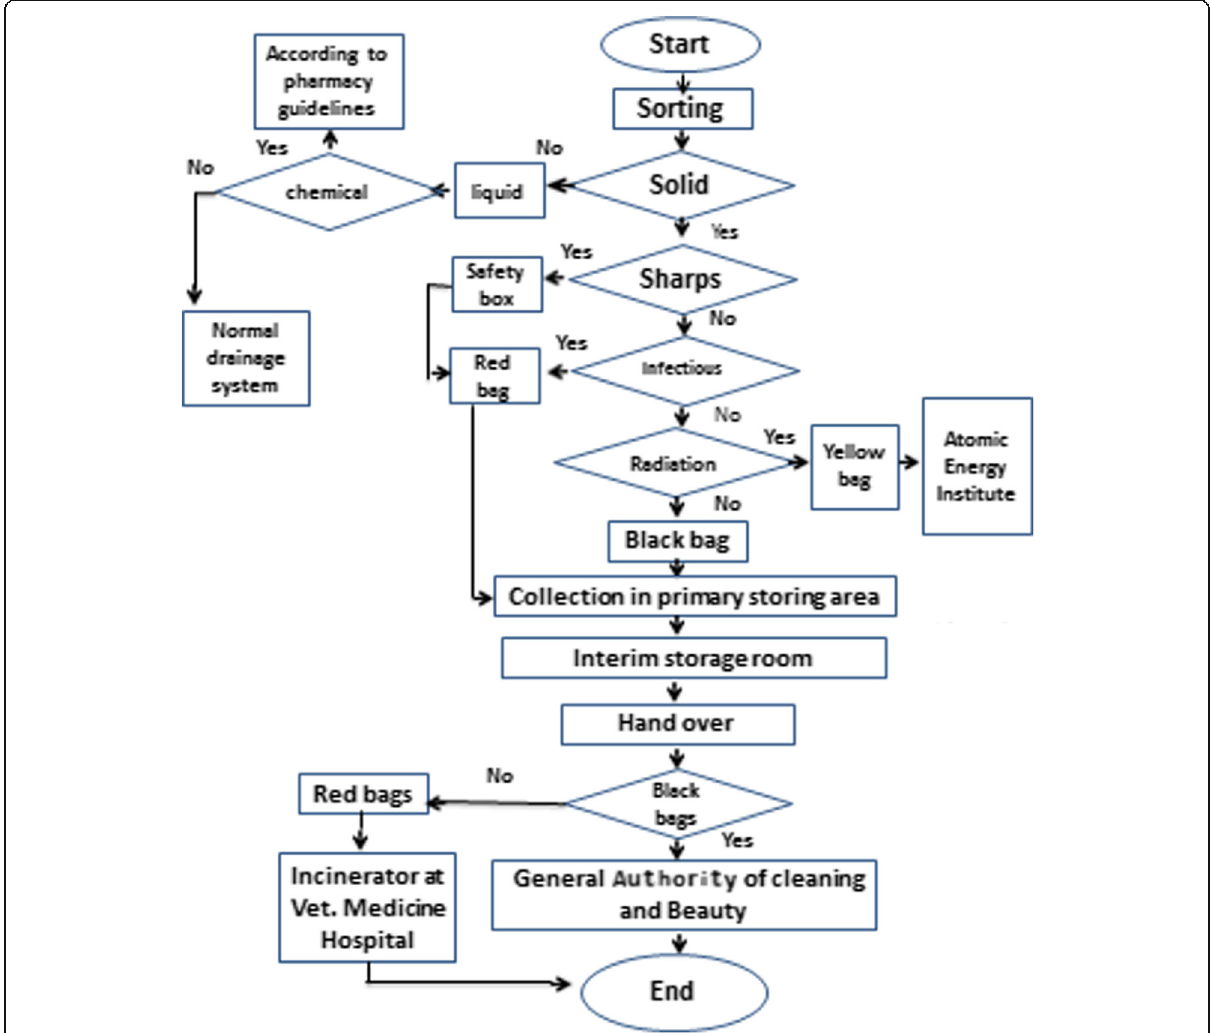
Fig. 5 High level flow diagram of steps of waste management